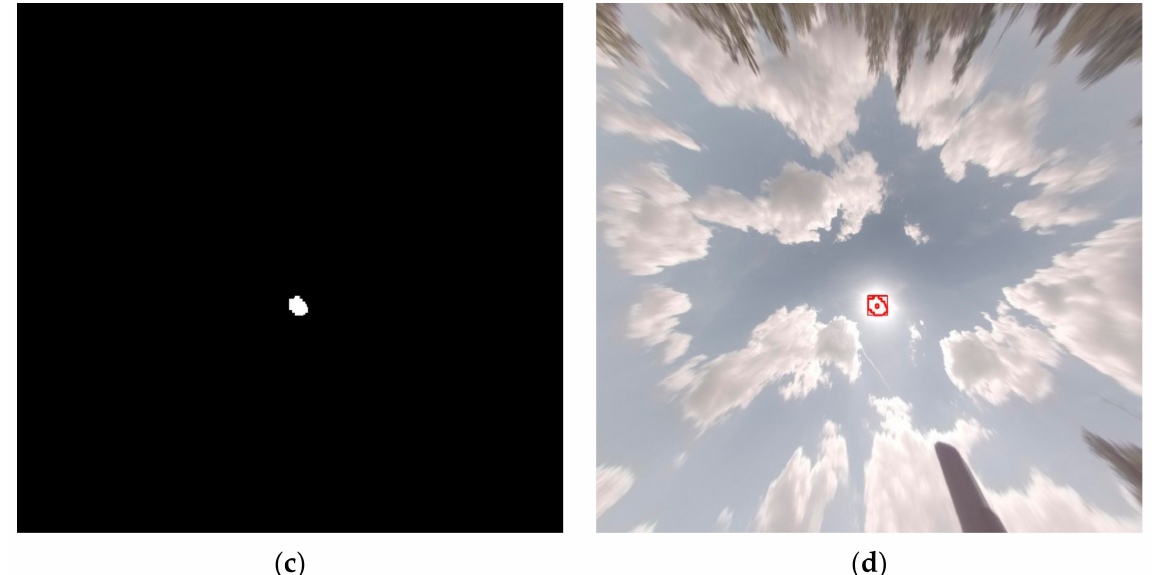
Figure 6. Image processing process for sun detection: ( a ) original image, ( b ) HSV format of the image, ( c ) detected sun after erosion operation, and ( d ) detected sun contour with rectangular shape